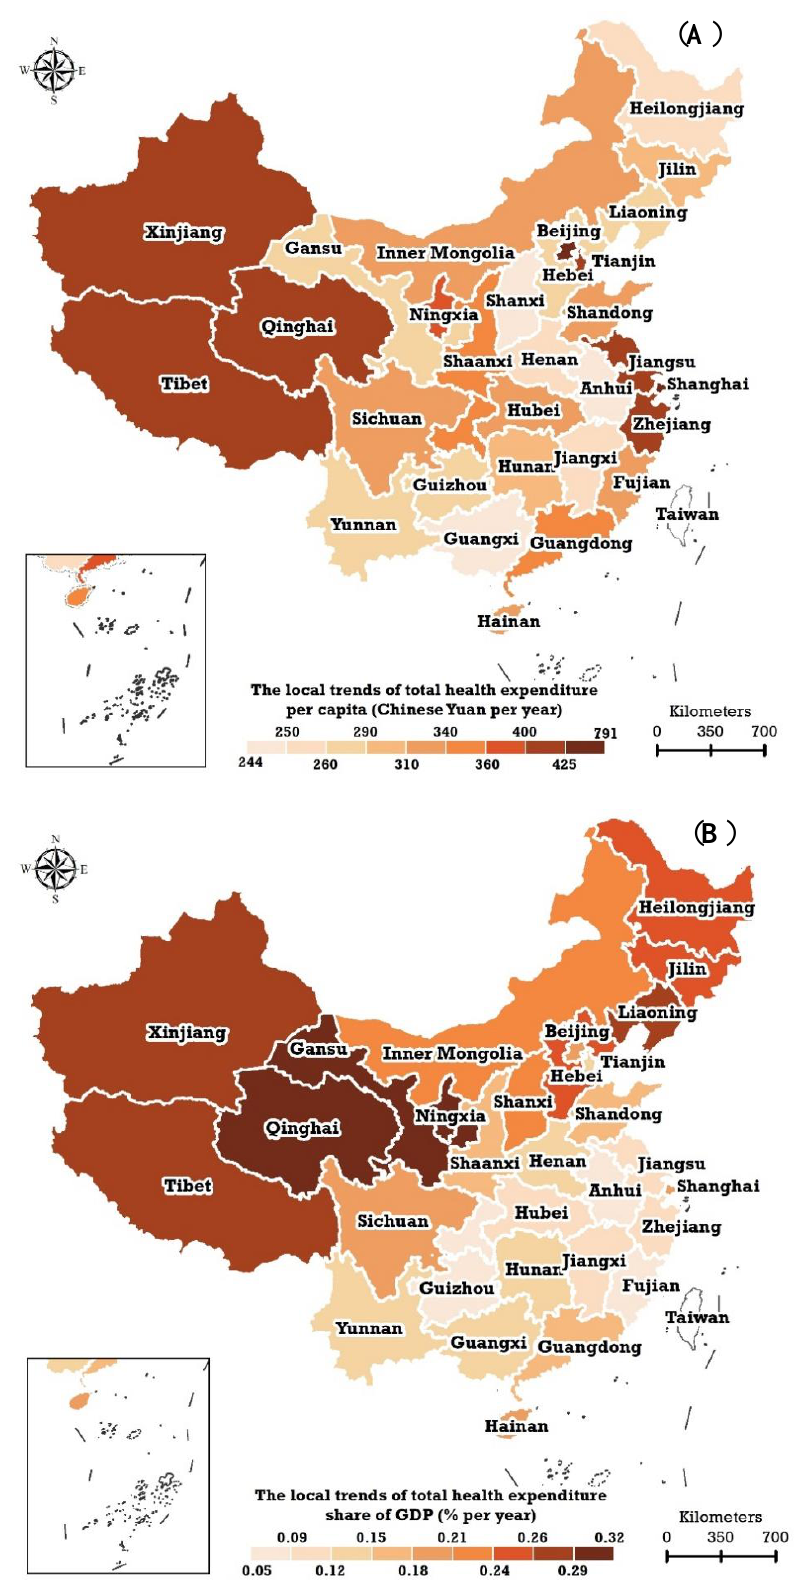
Figure 7. Local trends of ( A ) total health expenditure per capita Chinese yuan per year) and ( B ) total health expenditure as a share of GDP (% per year) in China estimated using the Bayesian spatiotemporal hierarchy model.